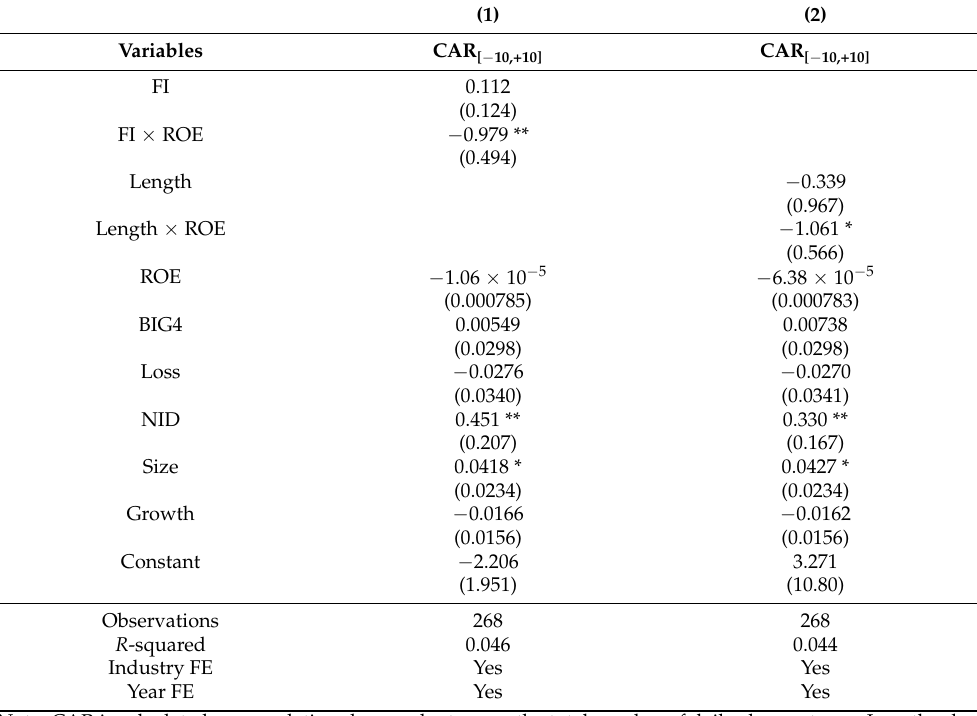
Table 3. Readability and cumulative abnormal returns.